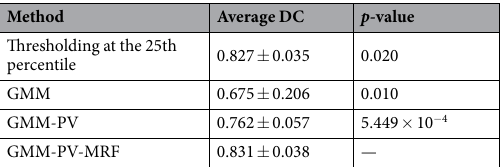
Table 4. Average Dice coefficients (DCs) ( ± standard deviations) for automatic segmentations of myelin- like signals in brainstem compared with manual segmentations for 16 test subjects aged between 29 and 44 gestational weeks. GMM-PV-MRF is compared with all the other methods using two-tailed Student’s t -tests at the 5% significance level.